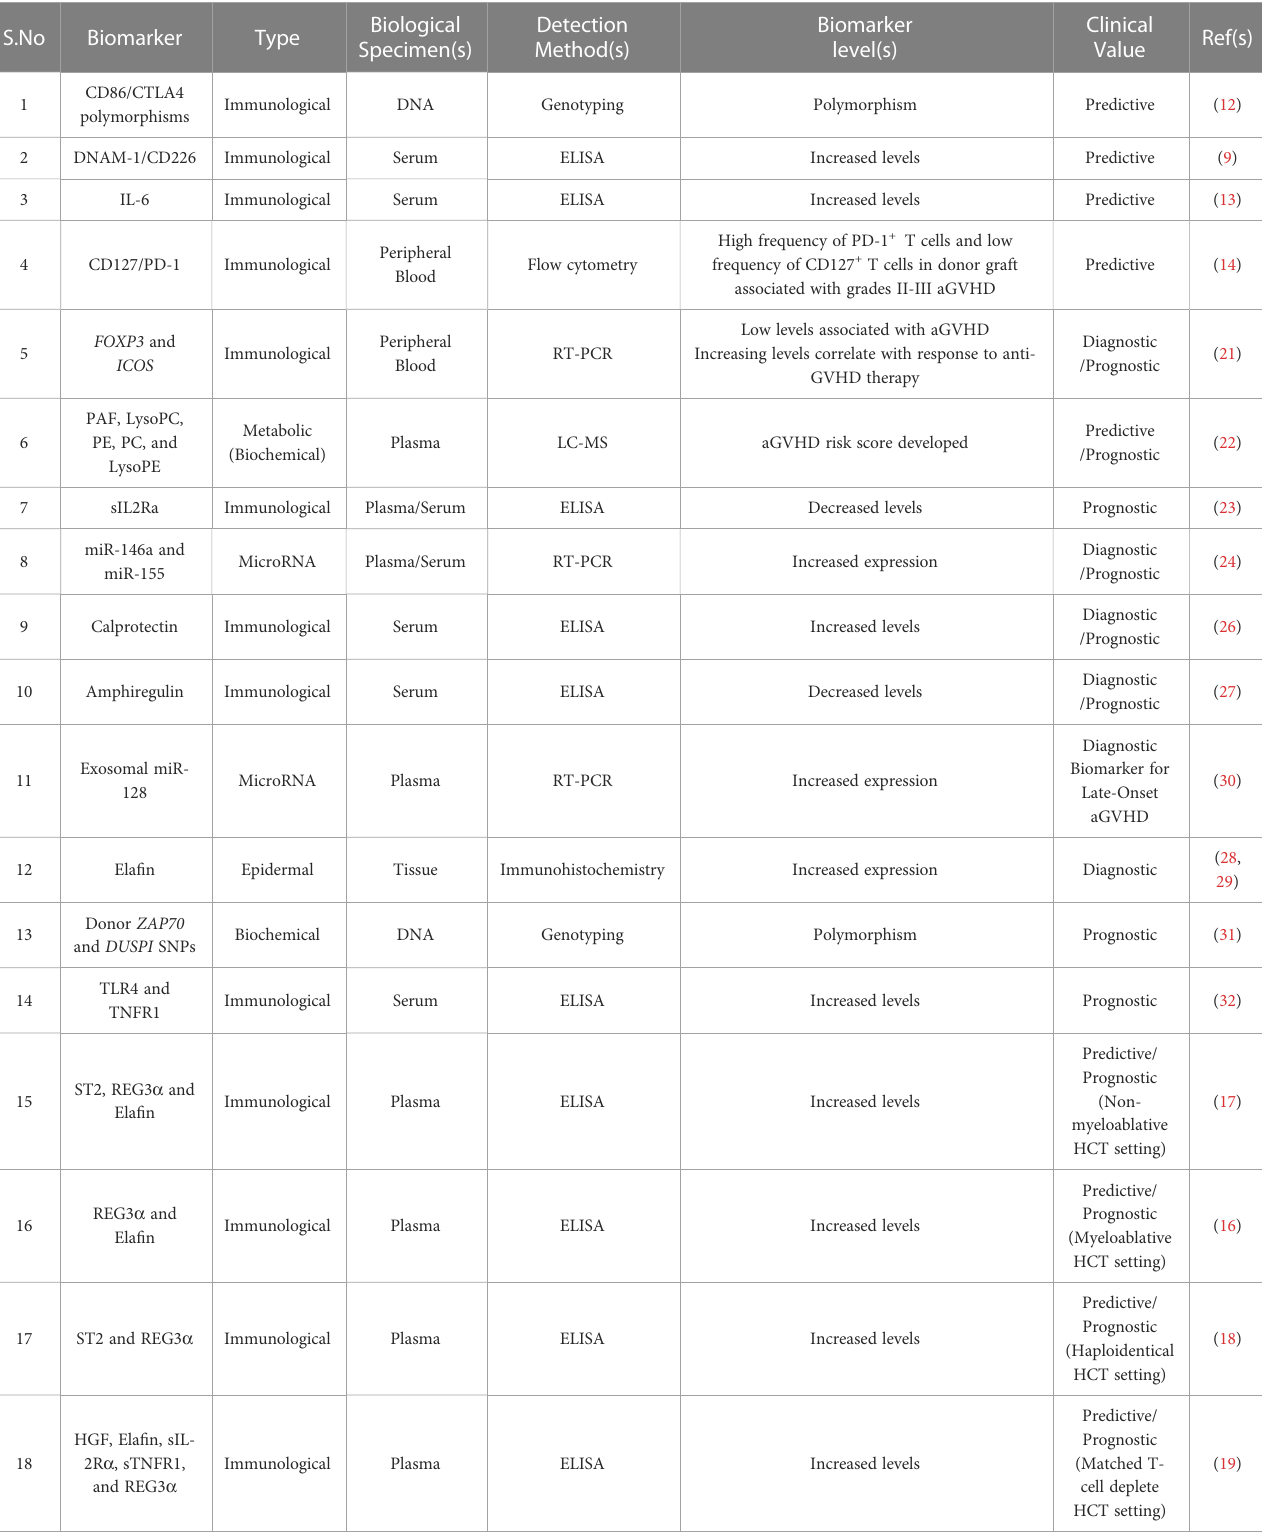
TABLE 1 List of various types of biomarkers with clinical values that could help in the prediction, diagnosis, or prognosis for Acute GVHD.